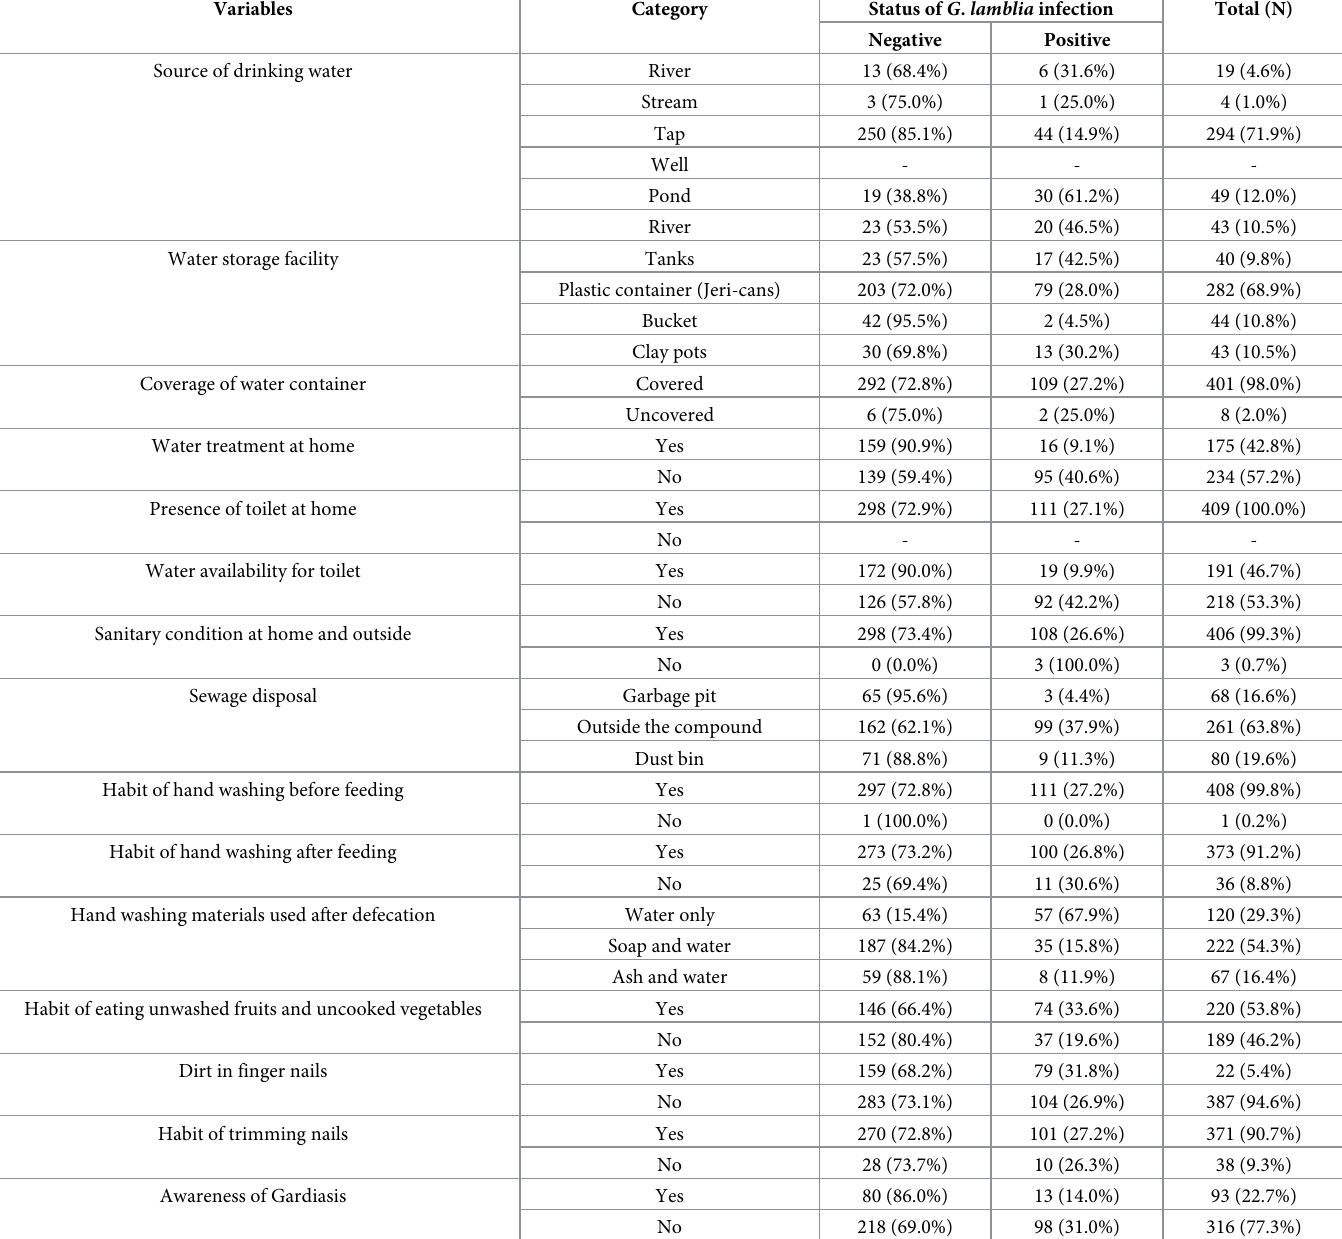
Table 3. Behavioral and environmental related risk factors related to G . lamblia infection of government elementary school students from Lok Abaya town, Sidama zone, SNNPR,